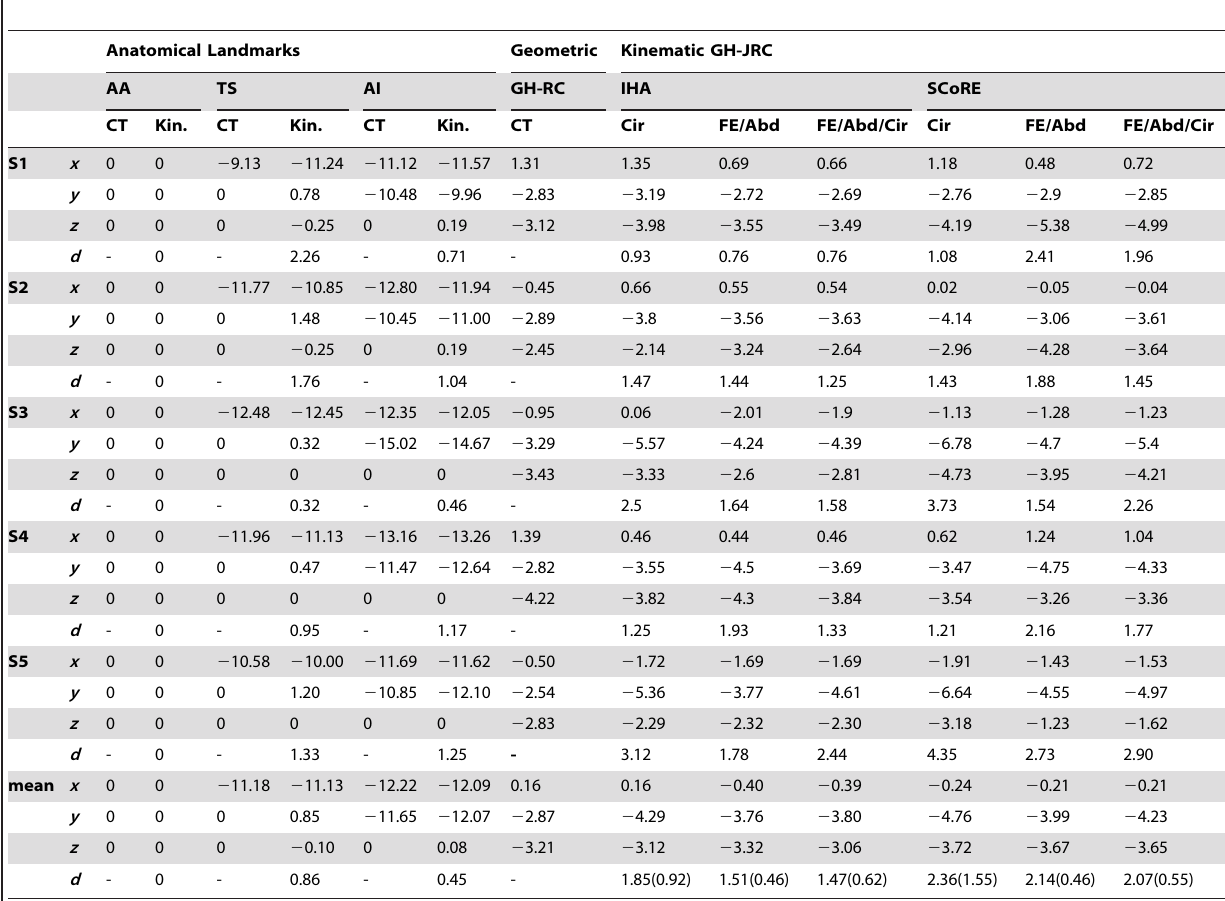
Table 3. The 3D positions of the scapular anatomical landmarks as well as the kinematic and geometric GH-JRC.